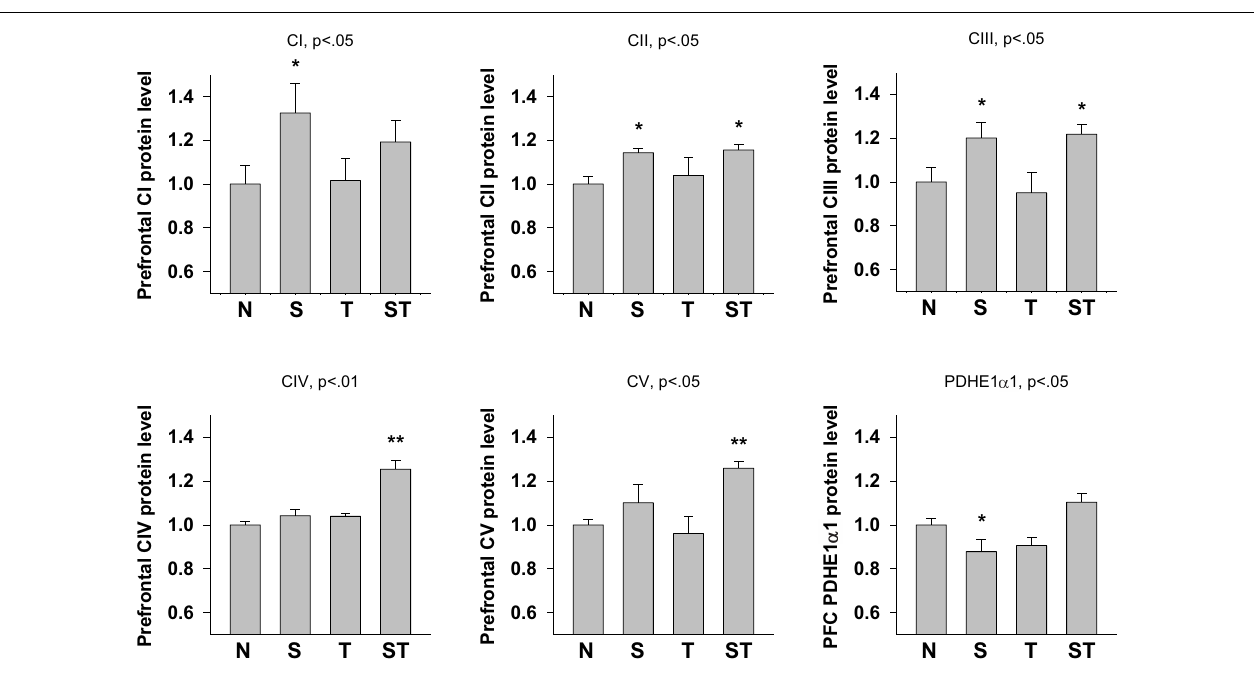
FIGURE 5 | Semi-quantitative determination of theWestern blotting protein bands density of ETC subunits CI, CII, CIII, CIV, CV proteins, and PDHE1 α 1 protein expressed in rat prefrontal cortex (PFC) 7days post